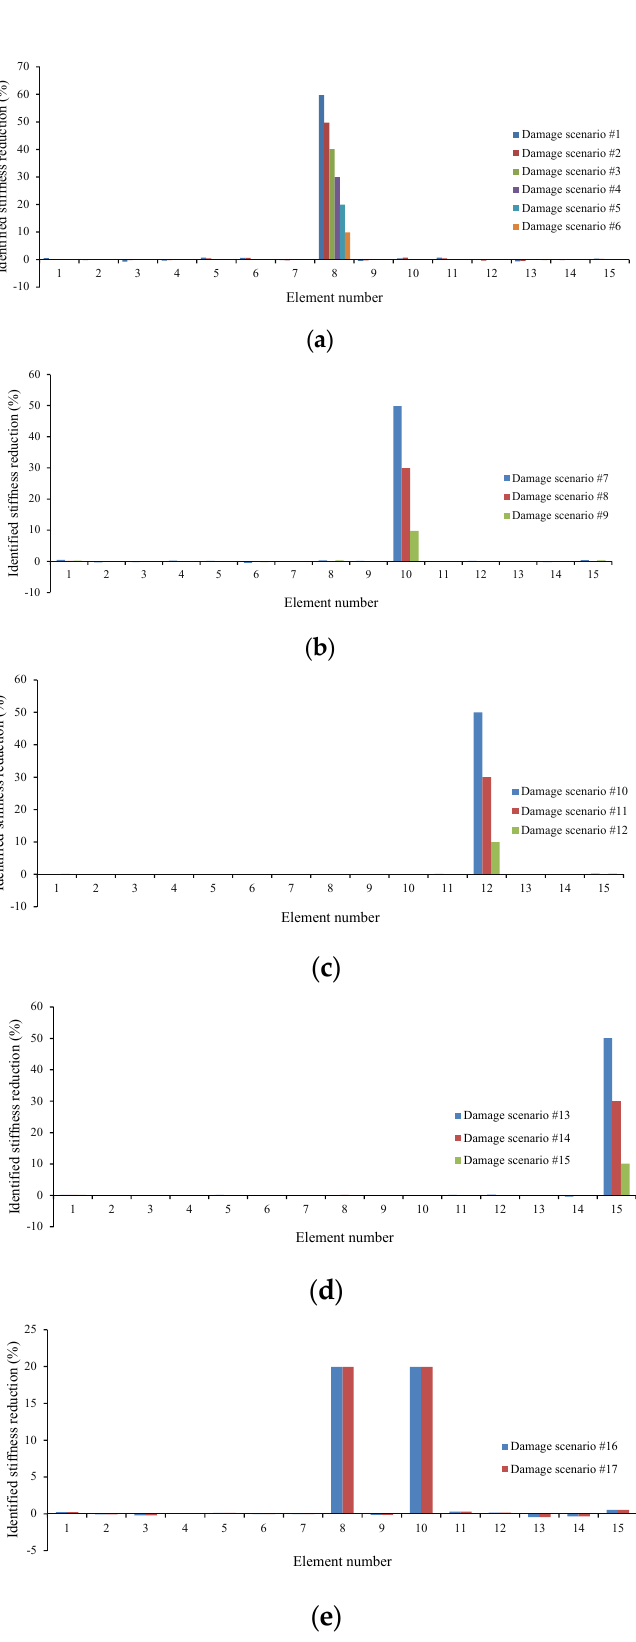
8 of 27 Table 2. Bridge parameters. L = 30 m EI = 2.5 × 10 10 N m 2 ρ A = 5 × 10 3 kg/m Damping ratio for all modes = 0.02 The efficiency of the proposed method subject to different damage scenarios, sensor placements, road surface roughness levels, vehicle speeds, and measurement noise levels have been investigated. The time step is 0.005 s in the simulations. The finite element model (FEM) of the bridge includes 15 Euler-Bernoulli beam elements, with 16 nodes. Each node has two degrees of freedom, rotation and vertical. Other assumptions of this numerical study are explained in Section 5.1. In this numerical study, measured accelerations have been simulated by a forward analysis of the vehicle-bridge interaction system using the explicit form of Newmark- β method. However, in practice, no prior knowledge of the road roughness and vehicle in- formation is required to apply this method. Only the axle spacing and vehicle speed are needed, which can both be easily obtained by the optical sensors installed at the entry and exit locations of the bridge. The percentage error of identified loads (I.L.), reconstructed response (Rec. Acc.), and damage identification error (D.I.), as well as the total time and the number of iterations (N.I.) to converge are investigated. The results are presented in Section 5.1 and discussed in Section 5.2. The system processor used in this study is an Intel ® Core ™ i7-4790 CPU @ 3.60 GHz and the installed memory (RAM) is 32.0 GB. MATLAB R2019B with company name of MathWorks is used for numerical analysis. 5.1. Identification Results 5.1.1. Effect of Damage Type In this section, a detailed study of the effects of damage location and its extension on the accuracy of the proposed method is carried out. Seventeen different damage scenarios